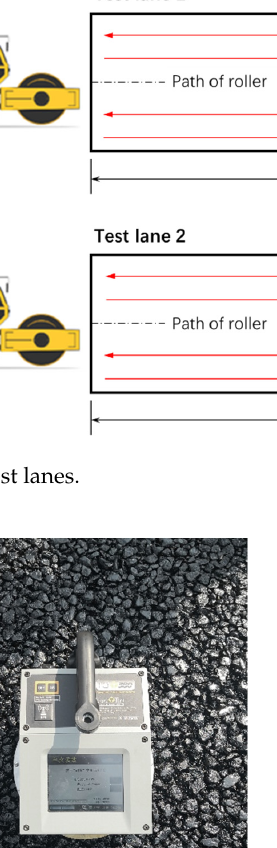
Figure 2. Accelerometer setup.